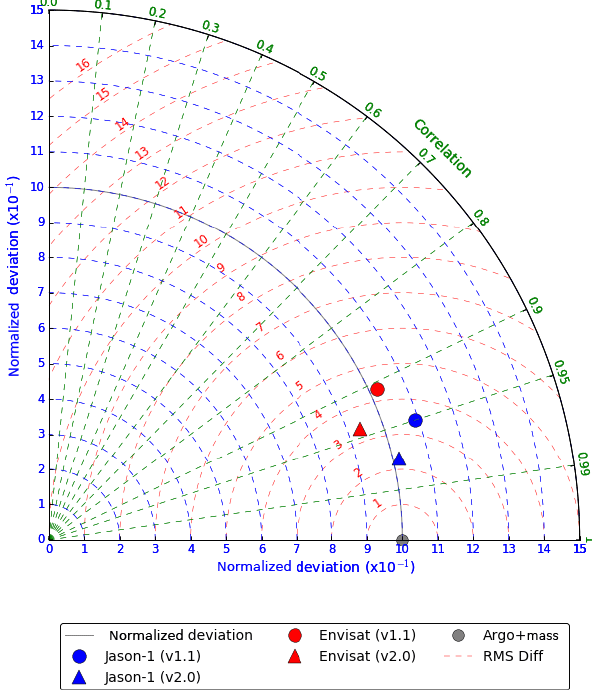
Figure 6. Taylor diagram of the annual signal of the Envisat (in red) and Jason-1 (in blue) sea level anomalies (2005–2012) calcu- lated considering the pole tide corrections derived both by Wahr (1985) (circle, used in ECV v1.1) and by Desai (2015) (triangle). They are compared with the independent sea level estimation (grey dot) derived from the in situ Argo dynamic heights anomalies (refer- enced to 900dbar) and the GRACE ocean mass contribution (GRGS